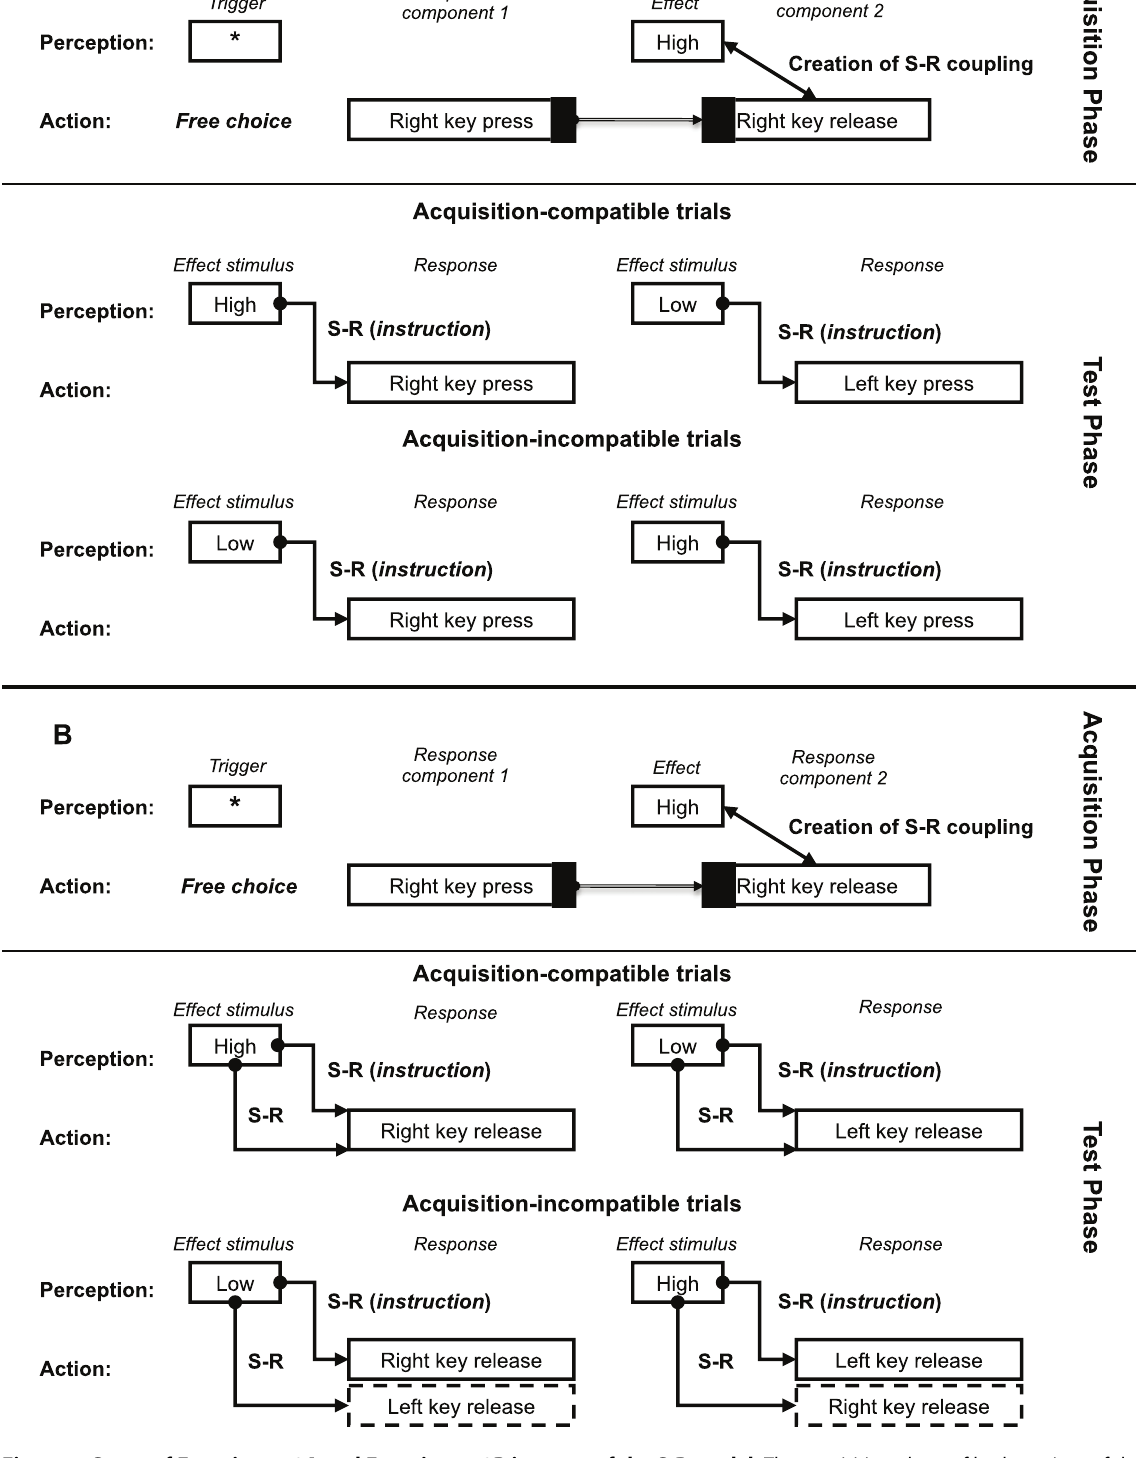
Figure 4. Setup of Experiment 3A and Experiment 3B in terms of the S-R model. The acquisition phase of both versions of the experiment was identical, consisting of two response components and without an imperative stimulus, such that they were performed in the ideomotor mode (for more details see text). ( A ) In the test phase of the key-press only version (Experiment 3A), response selection is not facilitated by the S-R coupling between Effect (tone) and Response component 2 (key release). ( B ) In the test phase of the key-release only version (Experiment 3B), this S-R coupling does influence response selection, leading to differences in response latencies between the compatible and incompatible conditions.